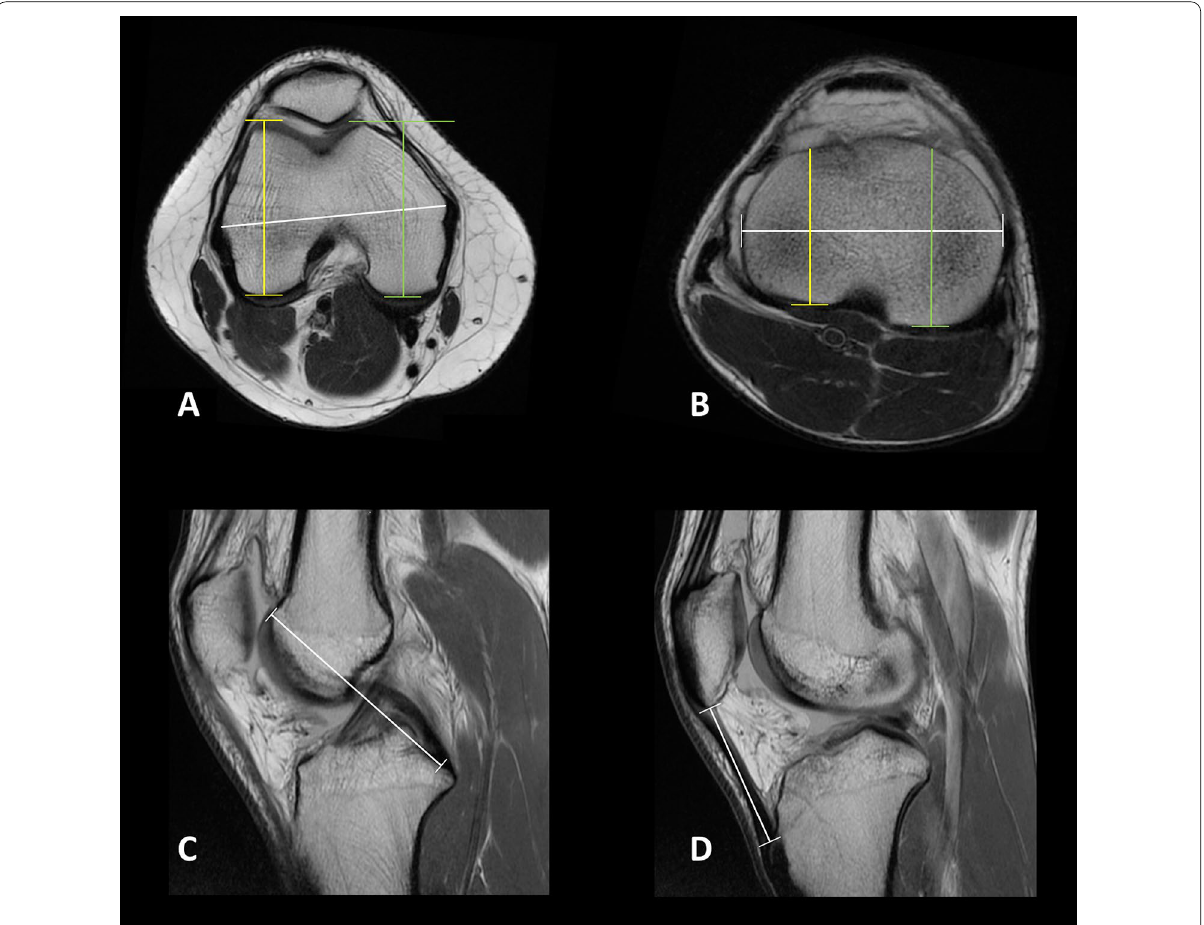
Fig. 1 2D measurements on T1-weighted MRI sequences: A Axial view of the femur: transepicondylar Distance (TD, white line), medial femoral condyle anteroposterior (AP) dimension (MFAP, green line), and lateral femoral condyle AP dimension (LFAP, yellow line), measured on axial cut. B Axial view of the tibia: proximal tibia medio-lateral dimension (PTML, white line), medial tibial plateau AP dimension (MTAP, green line), lateral tibial plateau AP dimension (LTAP, yellow line). C Sagittal view: posterior cruciate ligament and trochlear cartilage distance (PCLTC, white line). D Sagittal view: patellar tendon length (PTL, white